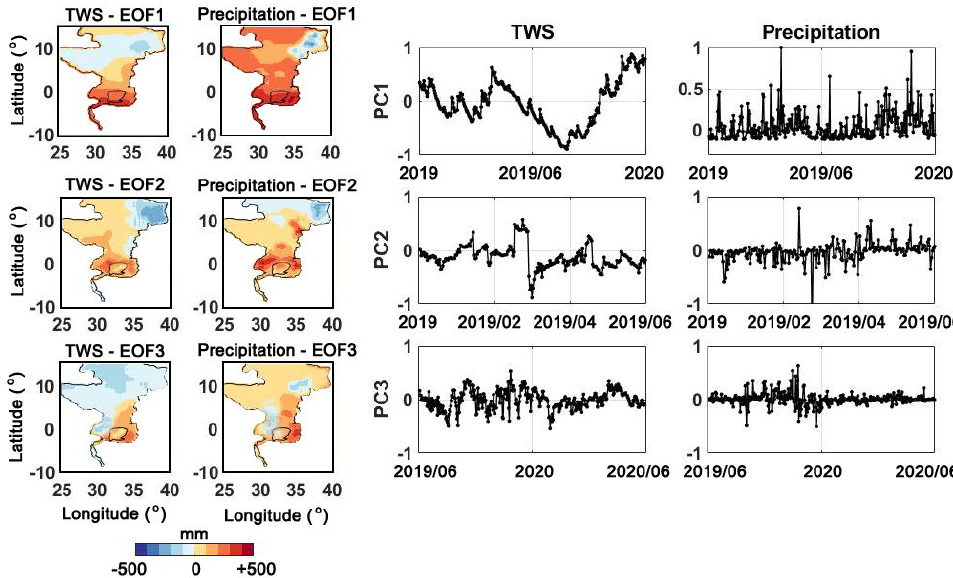
Figure 10. The first three components of PCA applied on TWS and precipitation time